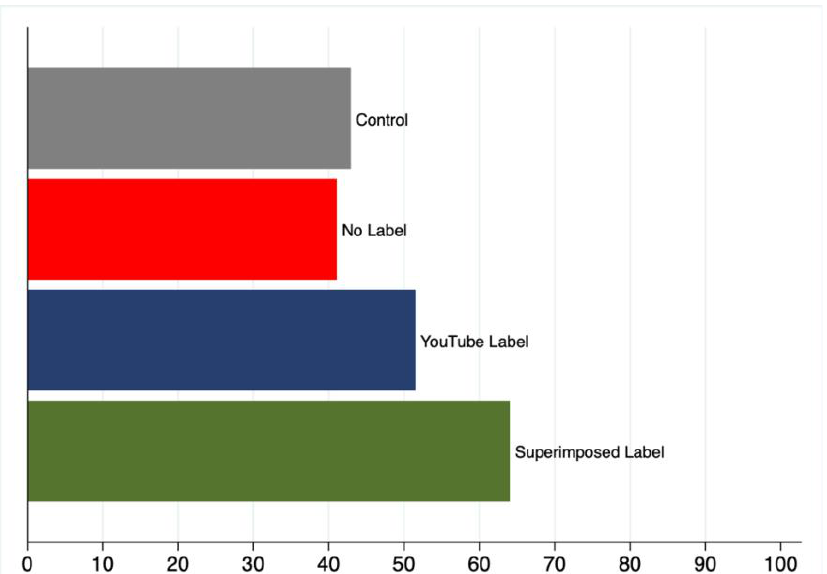
Figure 3. The percentage of participants who answered that RT was government funded in our second experiment, by